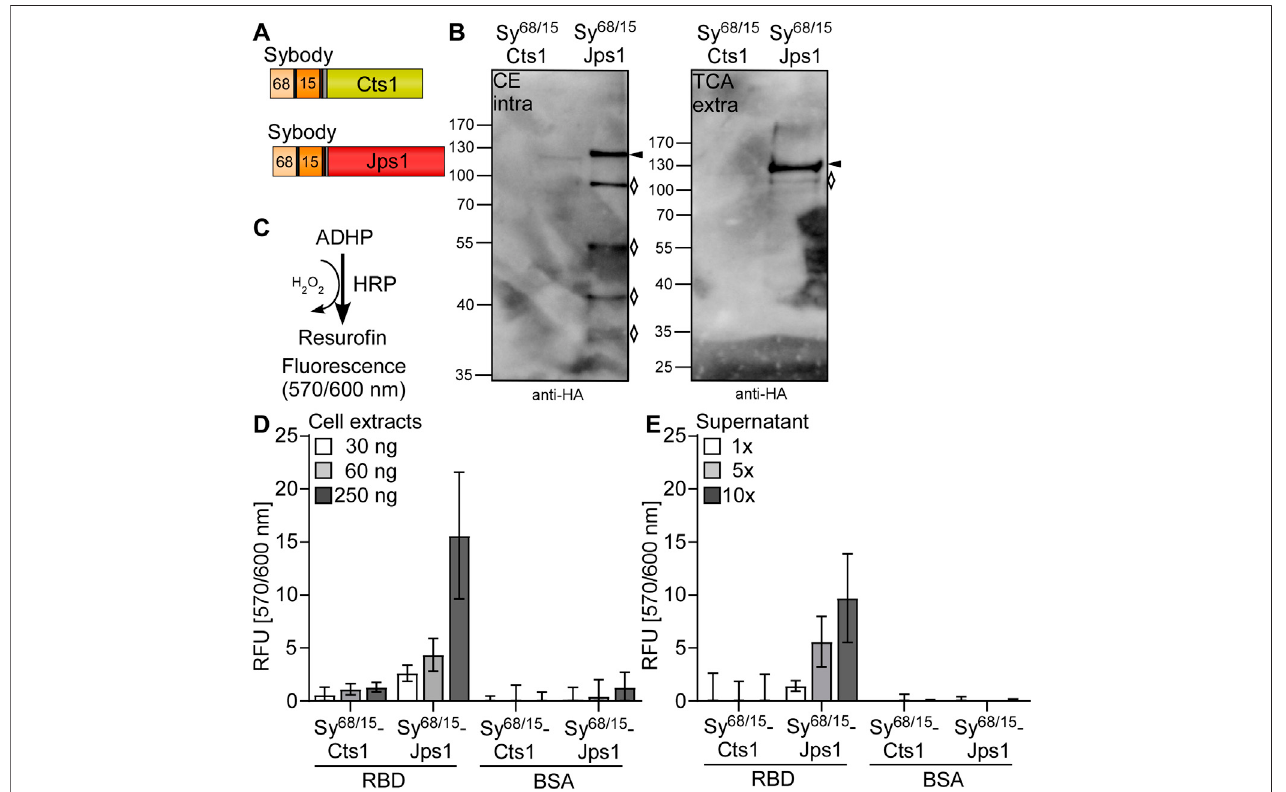
FIGURE 4 | Export of functional bi-speci fi c Sars-CoV2 sybodies using Jps1 as a carrier for unconventional secretion. (A) Bi-speci fi c anti SARS-CoV2 spike-RBD sybodies sy#15 and sy#68 (Walter et al., 2020) were tagged with a 10x His tag and fused to either Cts1 (top) or Jps1 (bottom) via a TEV protease cleavage site and an HA-tag. (B) Detection reaction for ELISA: Colorless 10-acetyl-3,7-dihydrophenoxazine (ADHP) is converted by horseradish peroxidase (HRP) using H 2 O 2 to resuro fi n, a purple substance that emits strong fl uorescence (excitation 570 nm, emission 600 nm). (C) Representative Western blot analyses of Sy 68/15 -Cts1 and Sy 68/15 - Jps1. Secreted protein was enriched from the supernatant by TCA precipitation. Intracellular protein levels were visualized by cell extracts. Western blots show 1 ml of precipitated supernatants (TCA) and 10 μ g cell extracts (CE). Full length protein signals indicated by arrows, degradation bands with rhombi. (D) ELISA of cell extracts: 1 µgofRBD wasimmobilized per well. 1µg BSAdealt asanegative control. Baseline wasestablished byawell coated withRBD and only treated withanti-HA and anti- mouse-HRP. Serial dilutions of U. maydis cell extracts (30 ng, 60 ng, 250 ng per well) were applied in technical triplicates both to RBD and BSA coated wells. Detection wascarriedoutwiththebeforementionedanti-HA-mouseandanti-mouse-HRPantibodies.Threebiologicalreplicatesareshown.Errorbarsindicatestandarddeviation of biological replicates. (E) ELISA of protein puri fi ed from supernatants: ELISA wells were coated, and reactions detected as described in (D) . Culture supernatants containing sybody-fusion proteins were subjected to Nickel 2+ -NTA IMAC and subsequently concentrated up to 10-fold. Serial dilutions of supernatants (1-fold, 5-fold, 10-fold concentrated supernatant) were mixed with blocking solution and added to ELISA wells in technical triplicates. Three biological replicates are shown. Error bars indicate standard deviation for biological replicates.